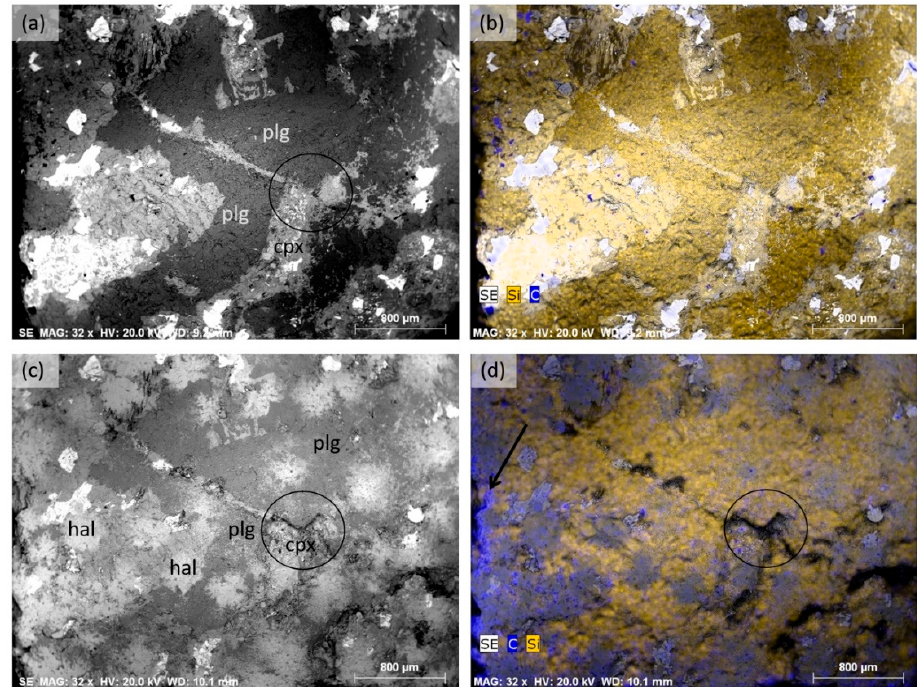
Figure 5. SEM images of a gabbro ‐ diorite specimen before (upper) and after (lower) SC CO 2 brine: ( a ) backscattered electron (BSE) images at 0 days; ( b ) BSE and EDS elemental maps distribution for silicon and carbon at 0 days; ( c ) BSE images after 64 days; and ( d ) BSE and EDS elemental maps distribution for silicon and carbon after 64 days, with preferential dissolution of clinopyroxene (circle) and carbon enrichment (organic accumulation) on the edge of specimen (arrow). plg—plagioclase, cpx— clinopyroxene, hal—halite.